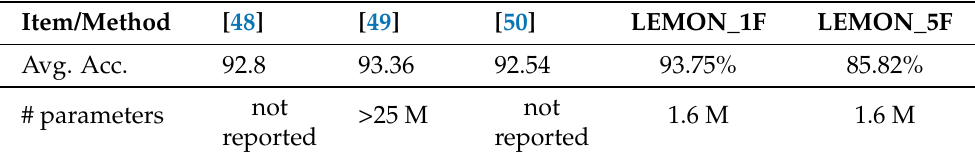
Table 11. Comparison of our approach, trained with one-fold and five-fold cross-validation, with respect to the state-of-the-art methods on the TFEID Dataset in terms of average accuracy and number of